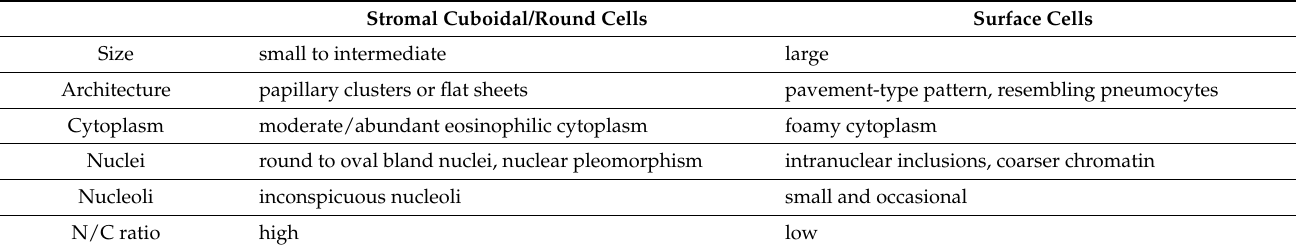
Table 1. Cytological findings of stromal and surface cells in pulmonary sclerosing pneumocytoma. Stromal Cuboidal/Round Cells